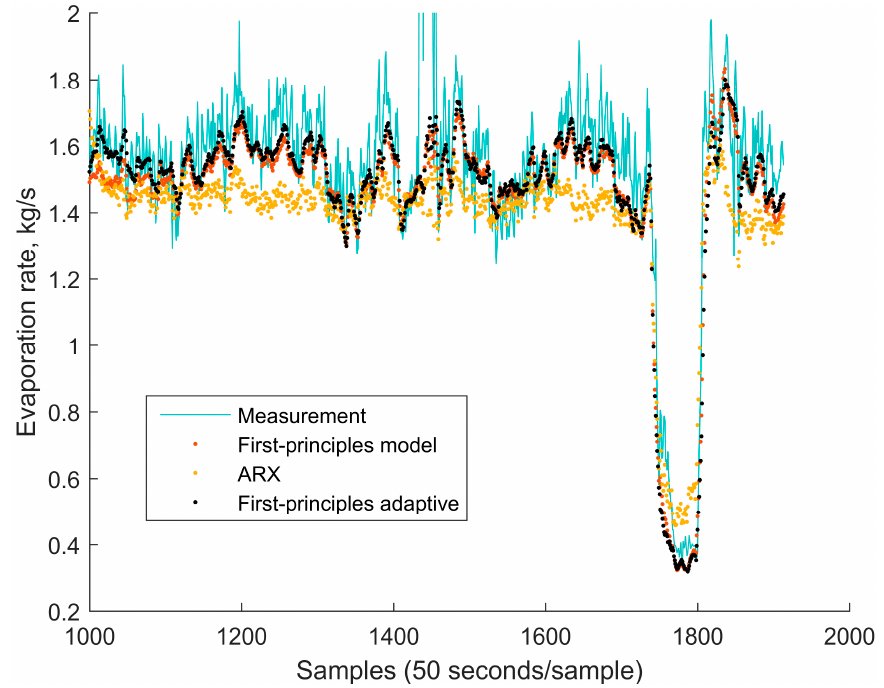
Figure 13. Comparison of evaporation rates predicted by the simplified dynamic model, ARX, and the adaptive simplified dynamic model.